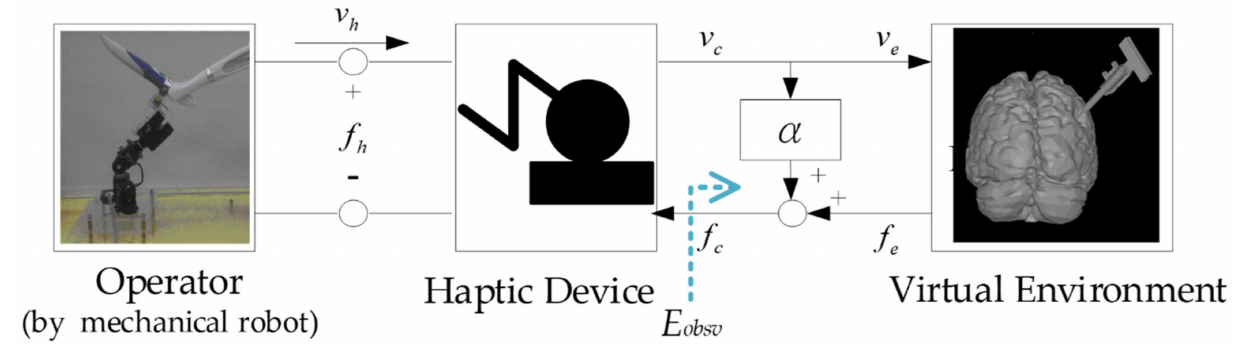
Figure 2. Block diagram of haptic feedback based augmented reality.